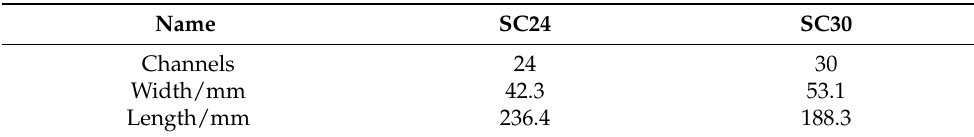
Table 6. Straight channel configurations for a geometric area of 100cm 2 with a channel width of 0.9mm.